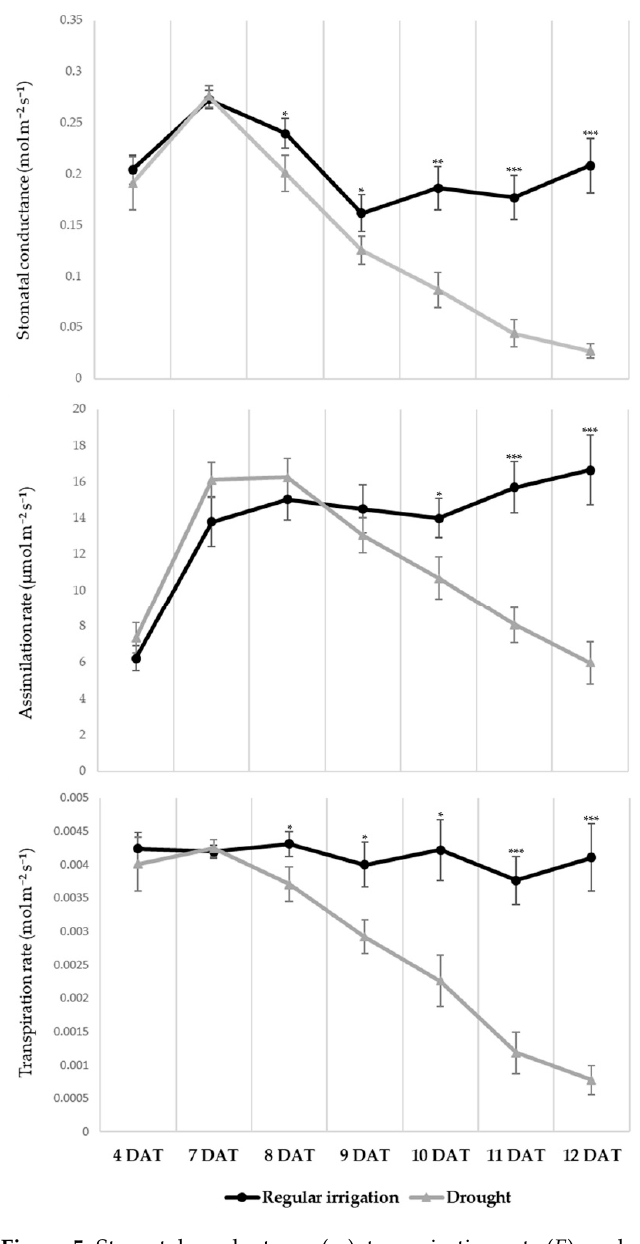
Figure 5. Stomatal conductance ( g s ), transpiration rate ( E ), and assimilation rate ( A ) changes under regular irrigation treatment and drought treatment from 4 to 12 DAT. Differences are represented as significant (*), highly significant (**), and extremely significant (***) at the 5%, 1%, and 0.1% levels, respectively, as determined by Student’s t test. The error bar indicates the standard deviation.